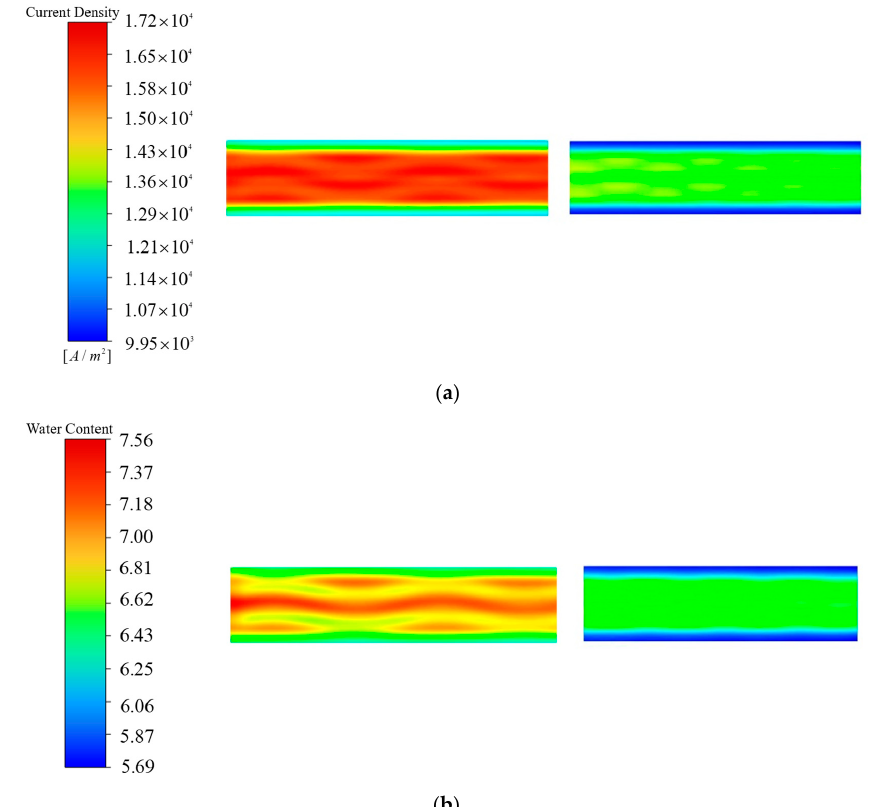
Figure 4. Simulation results of PEMFC model after calibration. ( a ) The current density distribution on the cathode side of the membrane; ( b ) The water content distribution on the cathode side of the membrane.